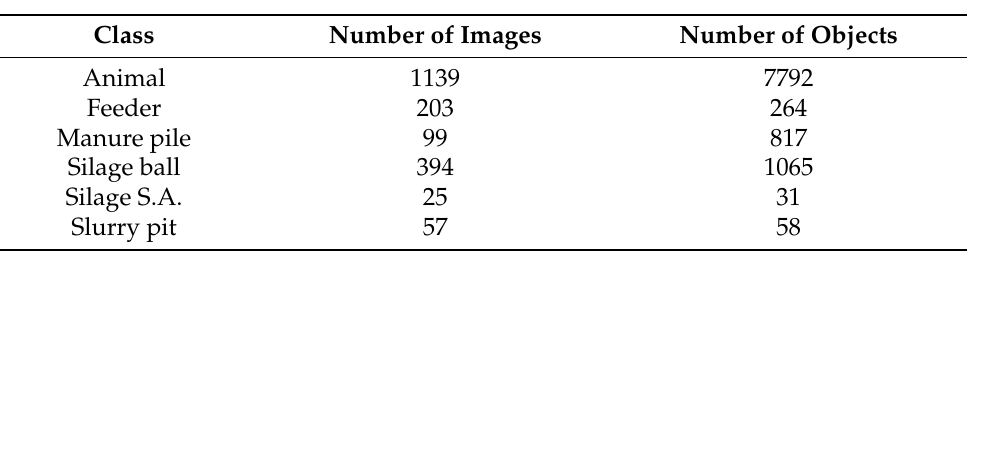
Figure 3. Object distribution per class of the augmented dataset. ( a ) analysis of the width of each class; ( b ) analysis of the height of each class. Table 3. Total number of images and instances used per class after applying an augmentation